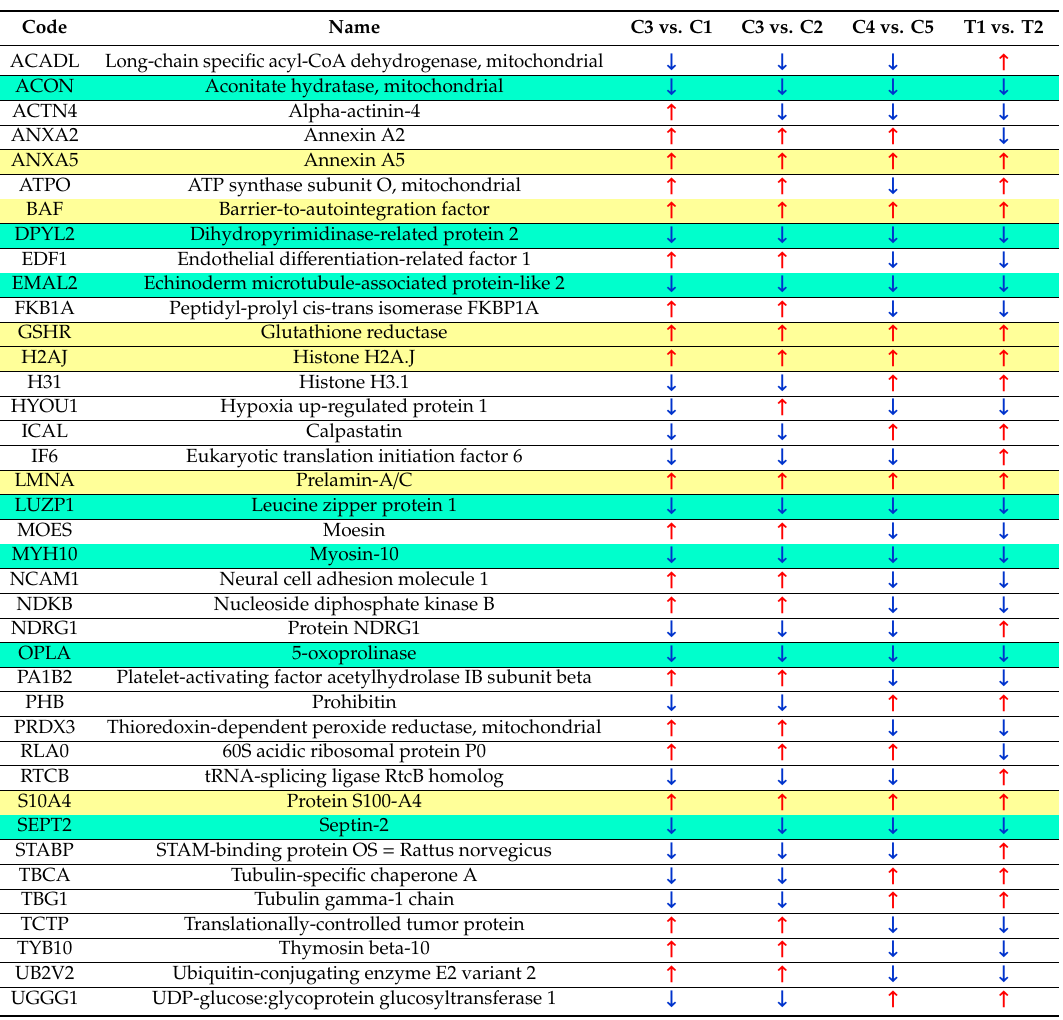
Table 2. List of candidate markers of interest, identified via the di ff erent methodological steps described in Figure 1B. The 13 proteins for which abundances changed significantly ( p < 0.05) in the same way in the di ff erent situations are highlighted in yellow (increase) or green